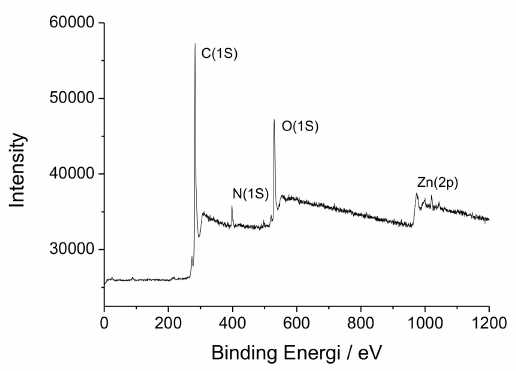
Figure 2. Overall X-ray photoelectron spectroscopy (XPS) spectrum of [Zn(BT)(NO 3 ) 2